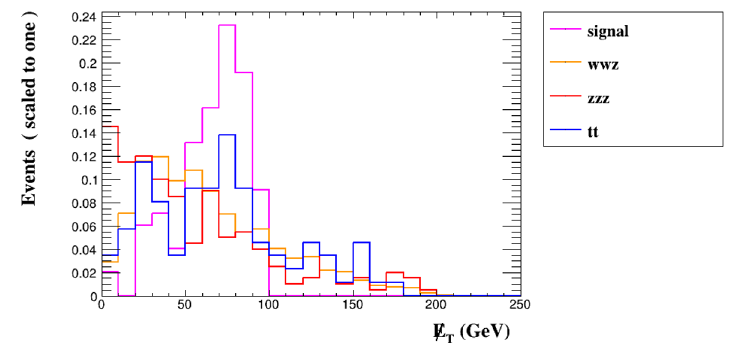
) for the signal and background com- T